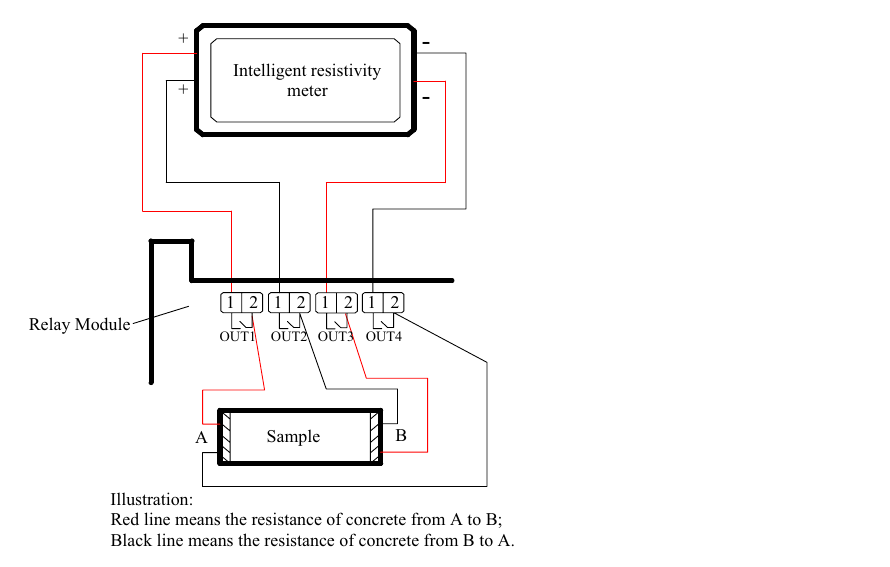
Figure 1. Working principle of the automatic concrete resistivity acquisition system.